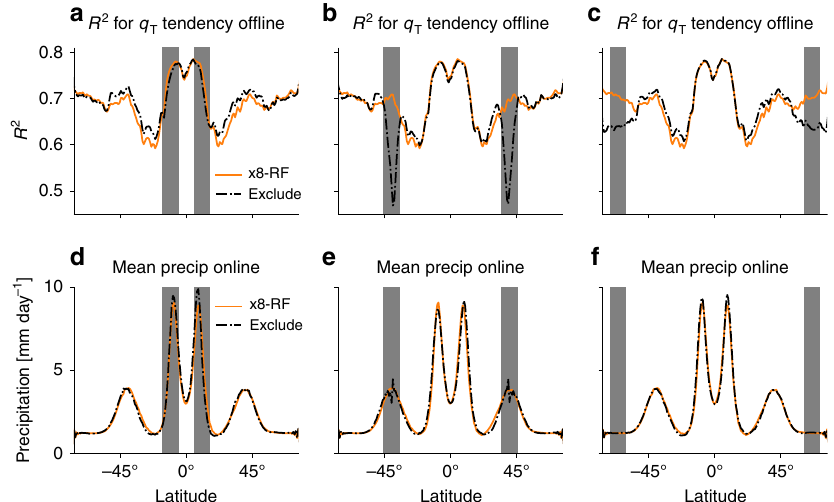
Fig. 5 Performance of random forest parameterization when excluding latitude bands during the training process. a – c Of fl ine performance at x8 as measured by R 2 of the tendency of q T (including all longitudes and levels) versus latitude, and d – f online performance as shown by the zonal- and time- mean precipitation for the x8-RF simulation. Results are shown in black dash-dotted for cases in which the training process excludes in both hemispheres the latitude bands a , d 5.1 ∘ – 15.5 ∘ , b , e 34.5 ∘ – 44.9 ∘ , and c , f 60.5 ∘ – 70.8 ∘ . Gray bars indicate latitude bands that where excluded during the training. For comparison the results for x8-RF without any latitudes excluded in training are plotted in